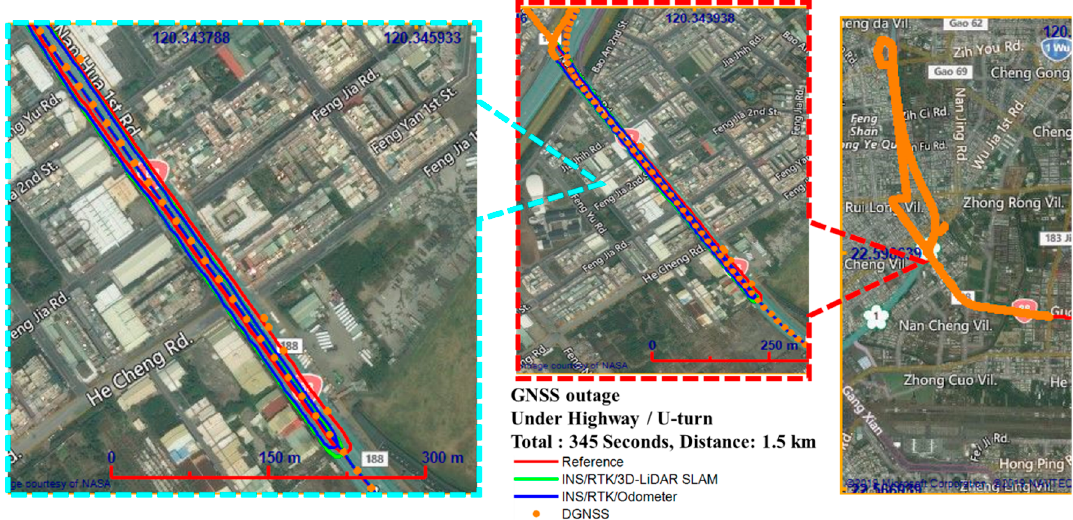
Figure 14. Scenario 2: zoomed area underneath the highway with a long-term GNSS outage and U-turn.